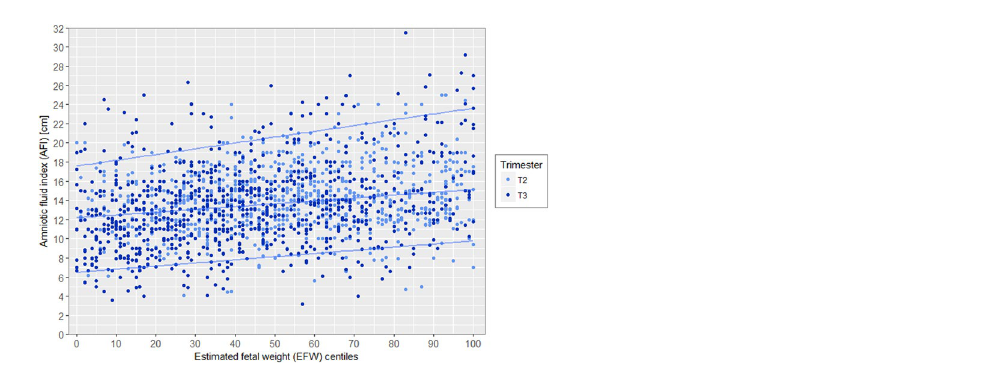
Figure 6. Distribution of amniotic fluid index (AFI) according to estimated fetal weight (EFW) in centiles and stratified by 2nd (18–28 weeks) and 3rd (29–40 weeks) trimester of